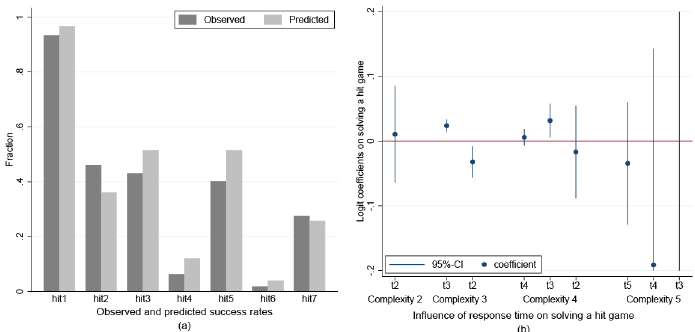
Fig 3. Success rates and response time analysis for the hit